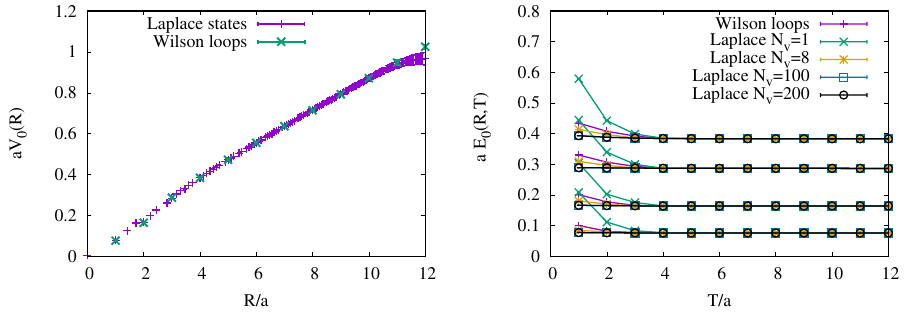
Figure 2. The static potential (left) and the first four e ff ective energies (right) on ensemble Em1 using the Laplacian eigenvector approach. The first is computed for all (!) on- and o ff -axis separations R / a and N v = 8, showing a flattening at half the lattice size R / a = 12 (left). The ground state overlap can be drastically improved by using more eigenvectors, see Table 1, we get earlier plateaus for larger N v .